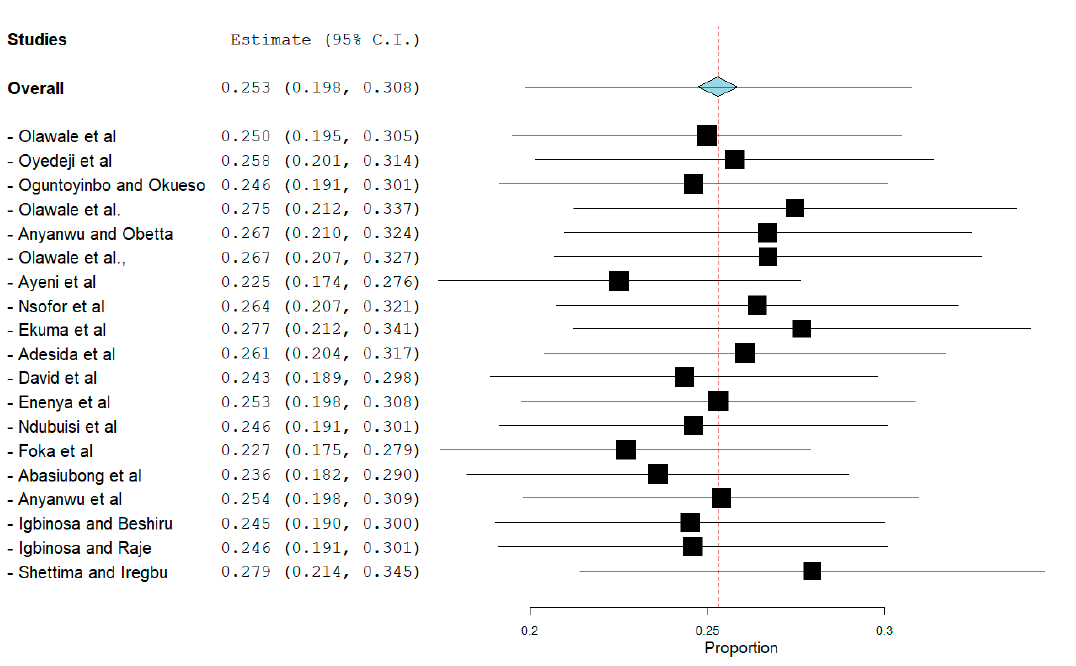
Figure 3. Forest plot showing the pooled prevalence of VRE in Nigeria.